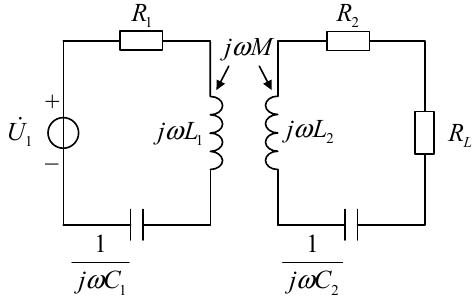
Figure 2. The equivalent circuit of WPT.